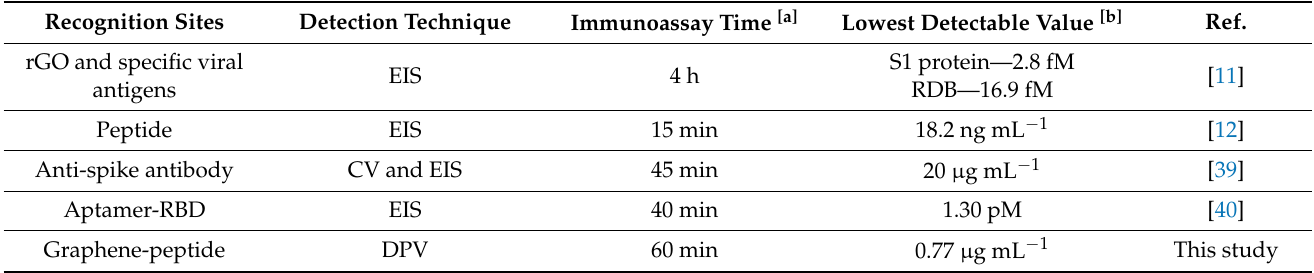
Table 1. Electrochemical biosensors applied in the detection of SARS-CoV-2: recognition sites, techniques, immunoassay time, and lowest detectable